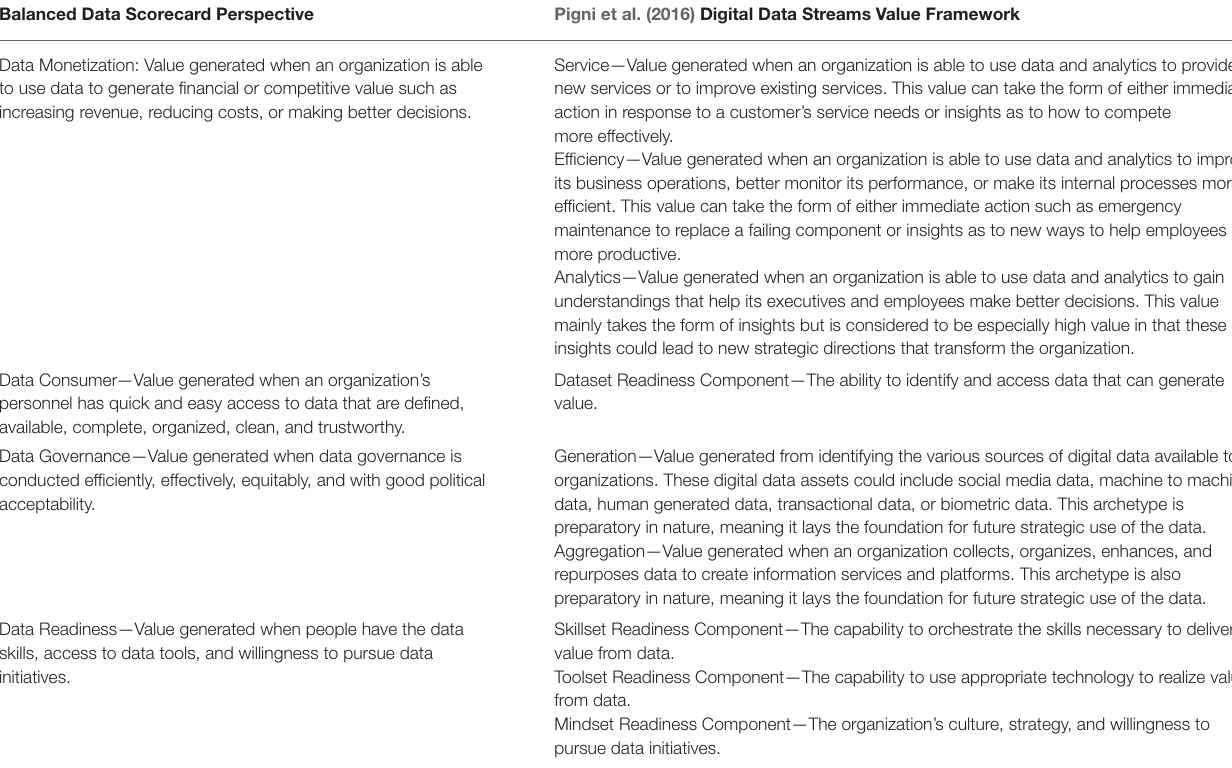
TABLE 2 | Overview of data scorecard perspectives and their roles in generating data value. Balanced Data Scorecard